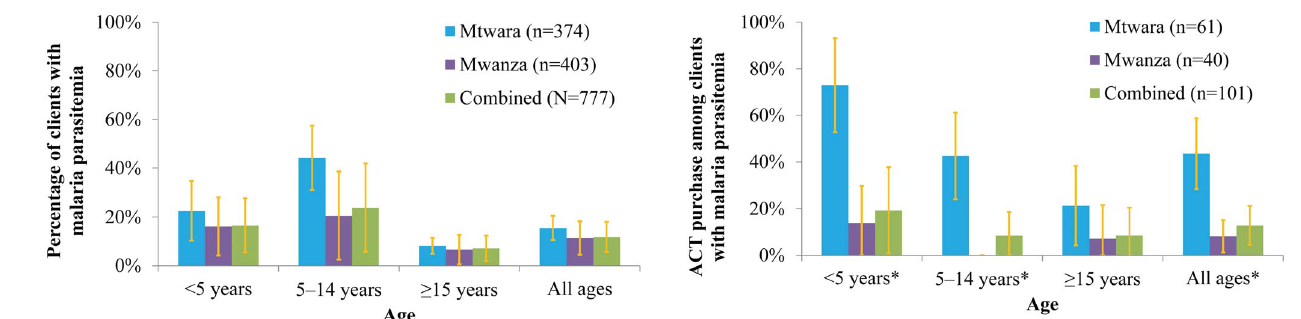
Table 4. Proportion of Clients With and Without Malaria Purchasing Antimalarials and Other Medications, Stratified by Region.